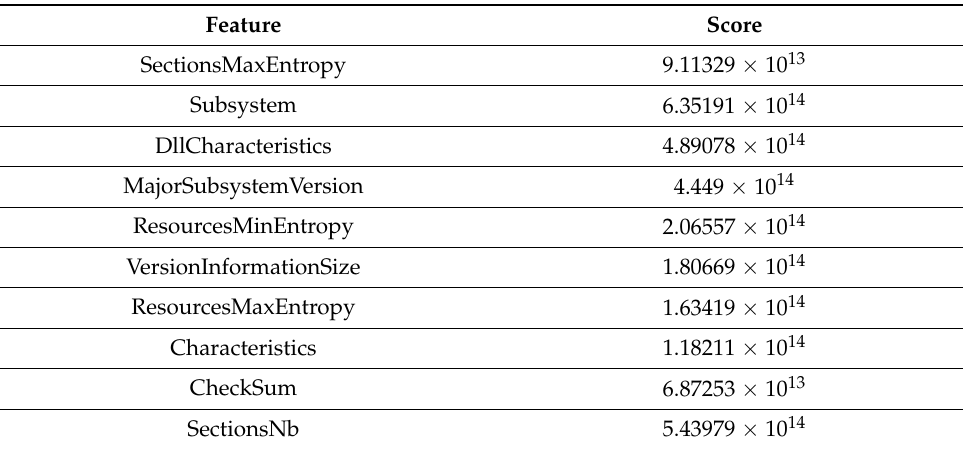
Table 1. Top 30 features based on their importance